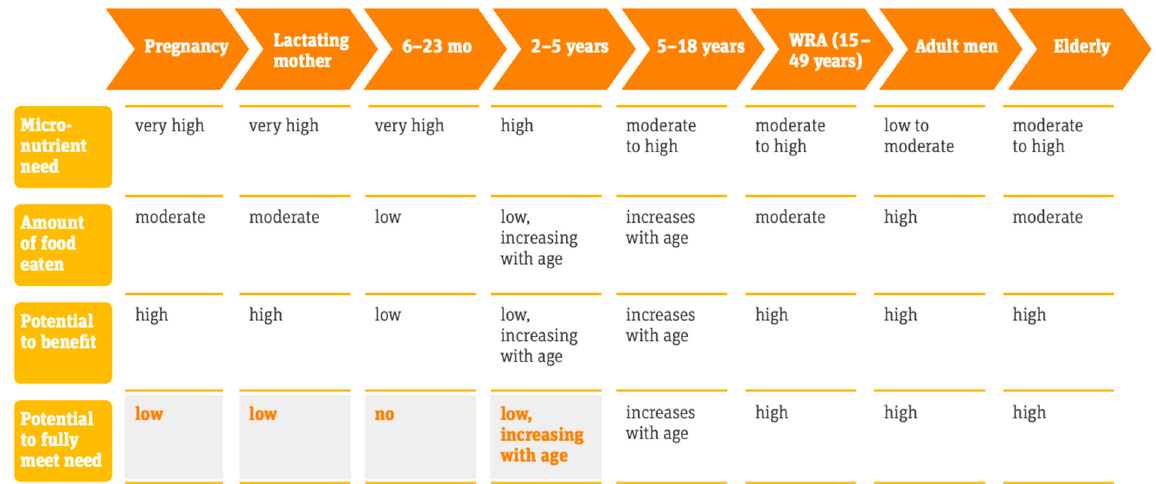
Figure 1. Potential benefits of food fortification across the life cycle. Source: Irizarry, L, Prost, MA, Murillo, D, Lopez de Romaña Daniel et al. 2017. Scaling Up Rice Fortification in Latin America and the Caribbean. World Food Programme and Sight and Life : 2017. WRA = Women of Reproductive Age.